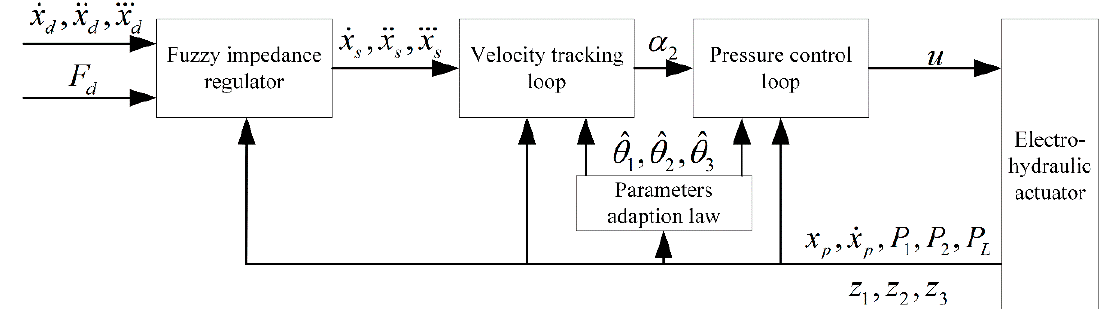
Figure 4. Schematic diagram of the proposed ARFIC control strategy.